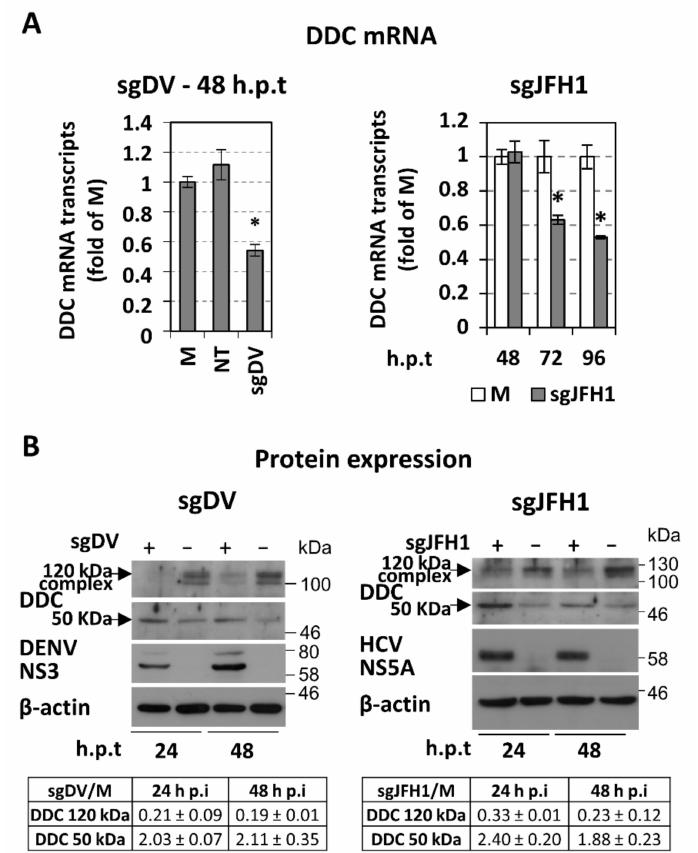
Figure 2. The e ff ect of DENV and HCV genome replication on the intracellular levels of DDC mRNA and protein. ( A , B ) Huh7 and Huh7-Lunet cells were electroporated with in vitro transcribed subgenomic reporter DENV-2 16,681 RNA (sgDV; left) or HCV JFH1 RNA (sgJFH1; right), respectively (10 µ g RNA / 4 × 10 6 cells), and further cultured for the indicated h p.t under 20% O 2 . Non-transfected (NT) cells or cells mock-electroporated with a capped-polyadenylated Renilla luciferase expressing RNA (M) were used as controls. ( A ) RT-qPCR analysis of the total DDC mRNA levels of DENV-replicon (left) and HCV-replicon (right) transfected cells. Values are expressed relative to the ones derived from non-transfected (NT) cells or mock-transfected (M) cells, at each time-point. YWHAZ mRNA levels were used for normalization. Bars represent mean values from three independent experiments in